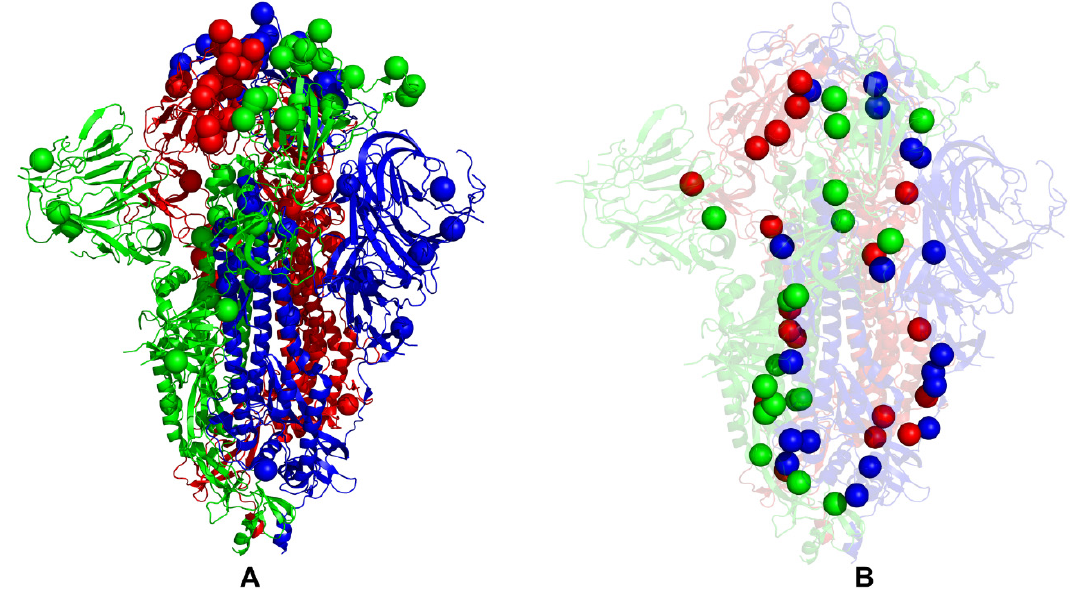
Figure 8. Structural maps of the functional sites for the SARS-CoV-2 S Omicron BA.1 closed trimer. ( A ) The structural mapping of the Omicron sites projected onto the cryo-EM structure of the closed S Omicron trimer (pdb id 7WK2). The three protomers A,B,C of the S Omicron trimers are shown in green, red and blue ribbons respectively. The Omicron mutational sites G339D, S371L, S373P, S375F, K417N, N440K, G446S, S477N, T478K, E484A, Q493R, G496S, Q498R, N501Y, Y505H, T547K, D614G, H655Y, N679K, P681H, N764K, D796Y, N856K, Q954H, N969K, and L981F are shown in spheres for all protomers and colored according to the protomer identity. ( B ) The structural mapping of the protein stability hotspots (Supplementary Materials Figure S1) onto the cryo-EM structure of the closed S Omicron trimer (pdb id 7WK3). The stability hotpots are shown in spheres colored according to the protomer identity.